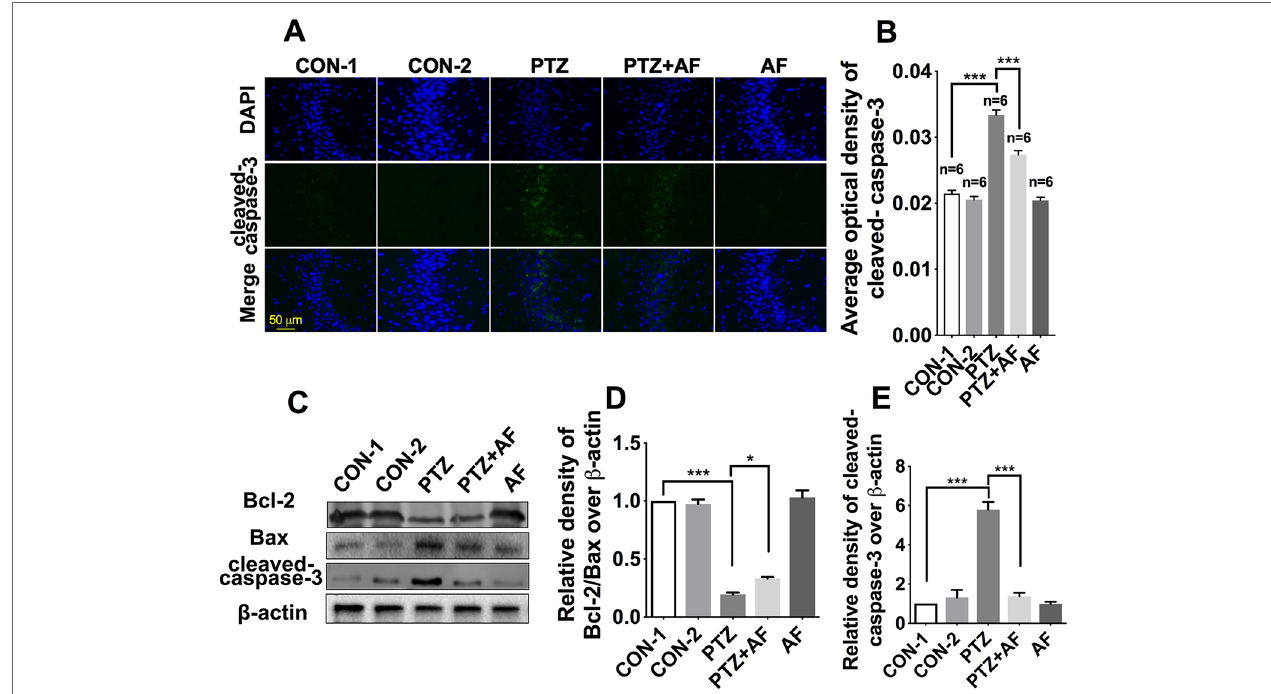
FIGURE 3 | Effects of amentoflavone on hippocampal neuronal apoptosis induced by PTZ kindling. (A) Representative images of immunofluorescence staining of cleaved caspase-3 in the hippocampus. (B) Semi-quantitative analysis of the relative levels of cleaved caspase-3 by densitometric analysis ( n = 6 mice per group, Student’s t test ). (C) Representative immunoblots of Bcl-2, Bax, and cleaved caspase-3 proteins in different groups. (D and E) Semi-quantitative analysis of the relative levels of Bcl-2/Bax and cleaved caspase-3 by densitometric analysis ( n = 6 mice per group, Student’s t test ). Error bars represent mean ± s.d. *, *** represent p < 0.05, p < 0.001, respectively. PTZ, pentylenetetrazole; AF,